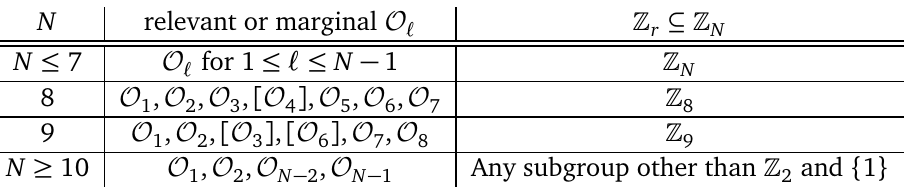
WZW CFT. Marginal 1 is abbreviated as O (cid:96) , N